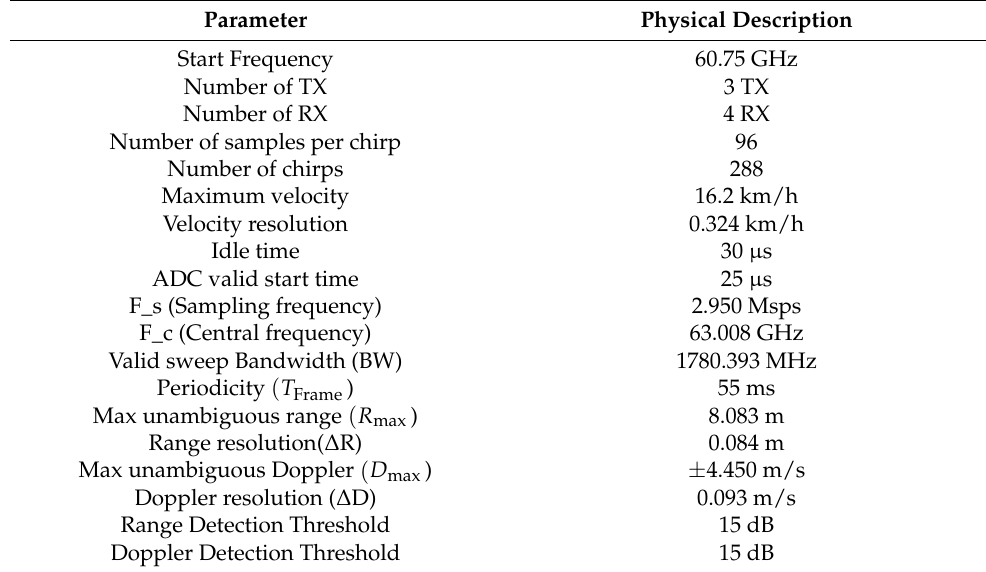
Table 1. IWR6843ISK-ODS Radar Parameters. Parameter